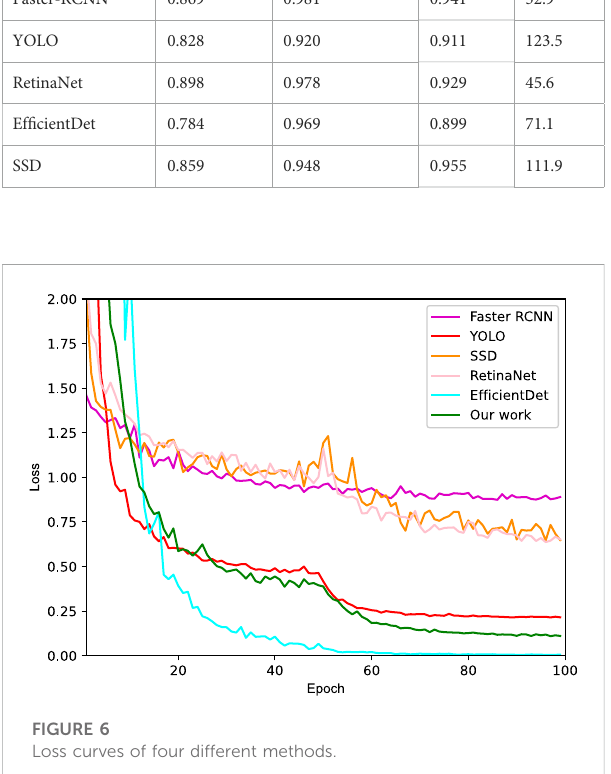
FIGURE 6 Loss curves of four different methods.